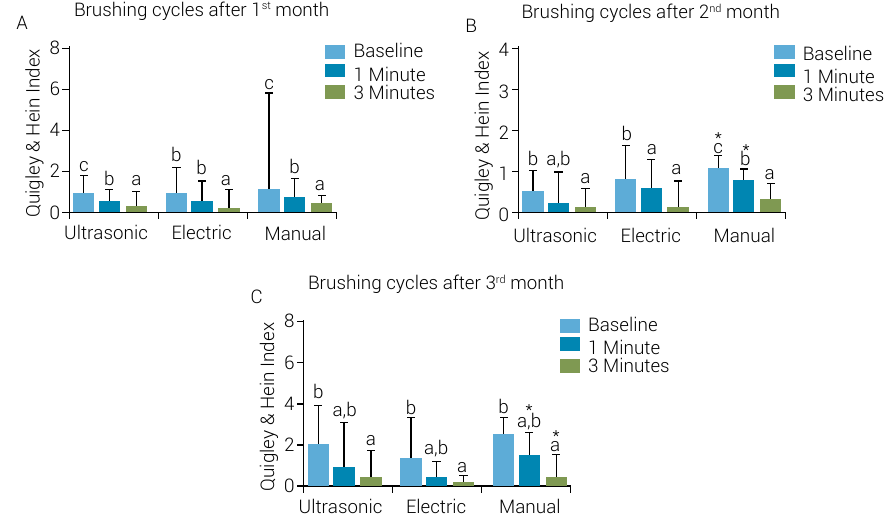
Figure 5. Representative graphs of the effect of plaque removal after the brushing cycles of 1 and 3 minutes performed at the A)1 st month, B) 2 nd month, and C)3 rd month after the toothbrushes use. Different letters represent statistical differences within each group-Friedman complemented by Dunn; *p<0.05-Higher plaque index than the US group at the 2 nd month-Kruskall-Wallis complemented by Dunn; #p<0.05-Higher plaque index than the E group at the 3 rd month-Kruskall-Wallis complemented by